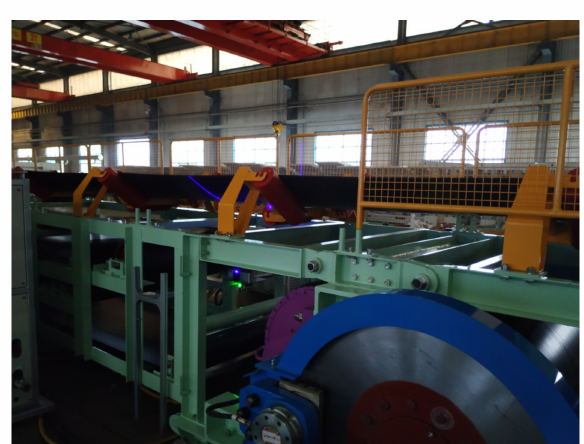
Figure 10. The experiment in industrial scene.